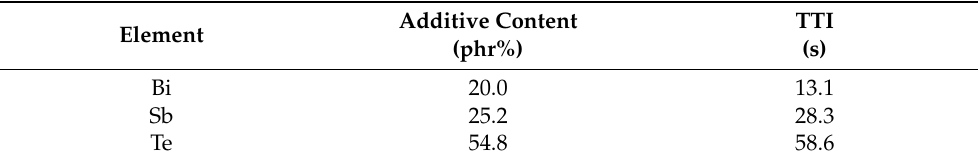
Table 1. Compositions of as-synthesized BST NPs estimated by EDS.